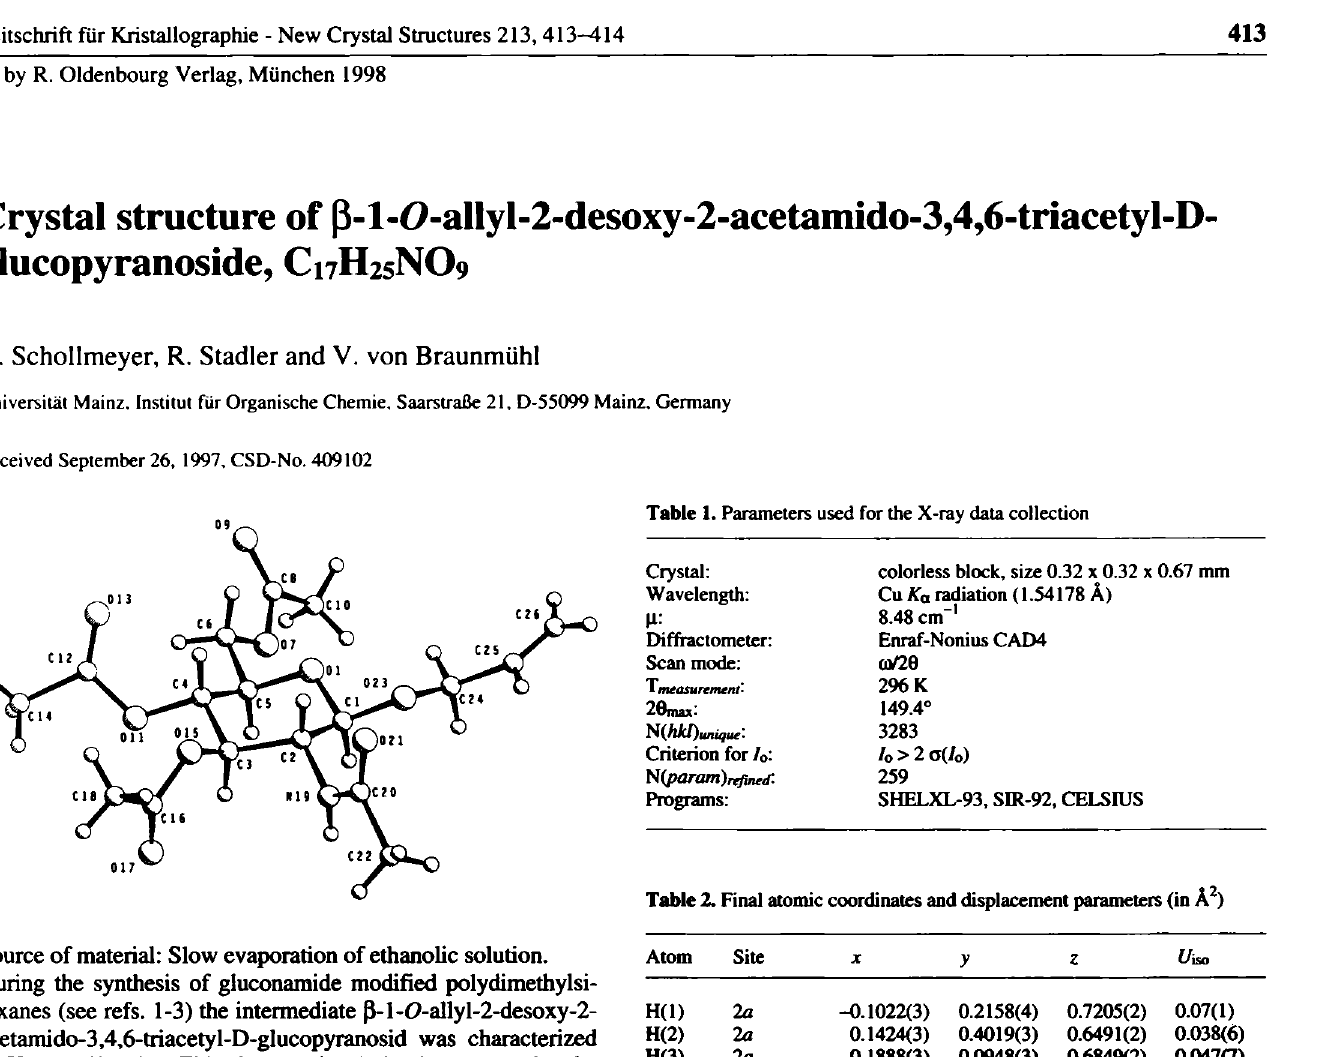
Table 2. Final atomic coordinates and displacement parameters (in